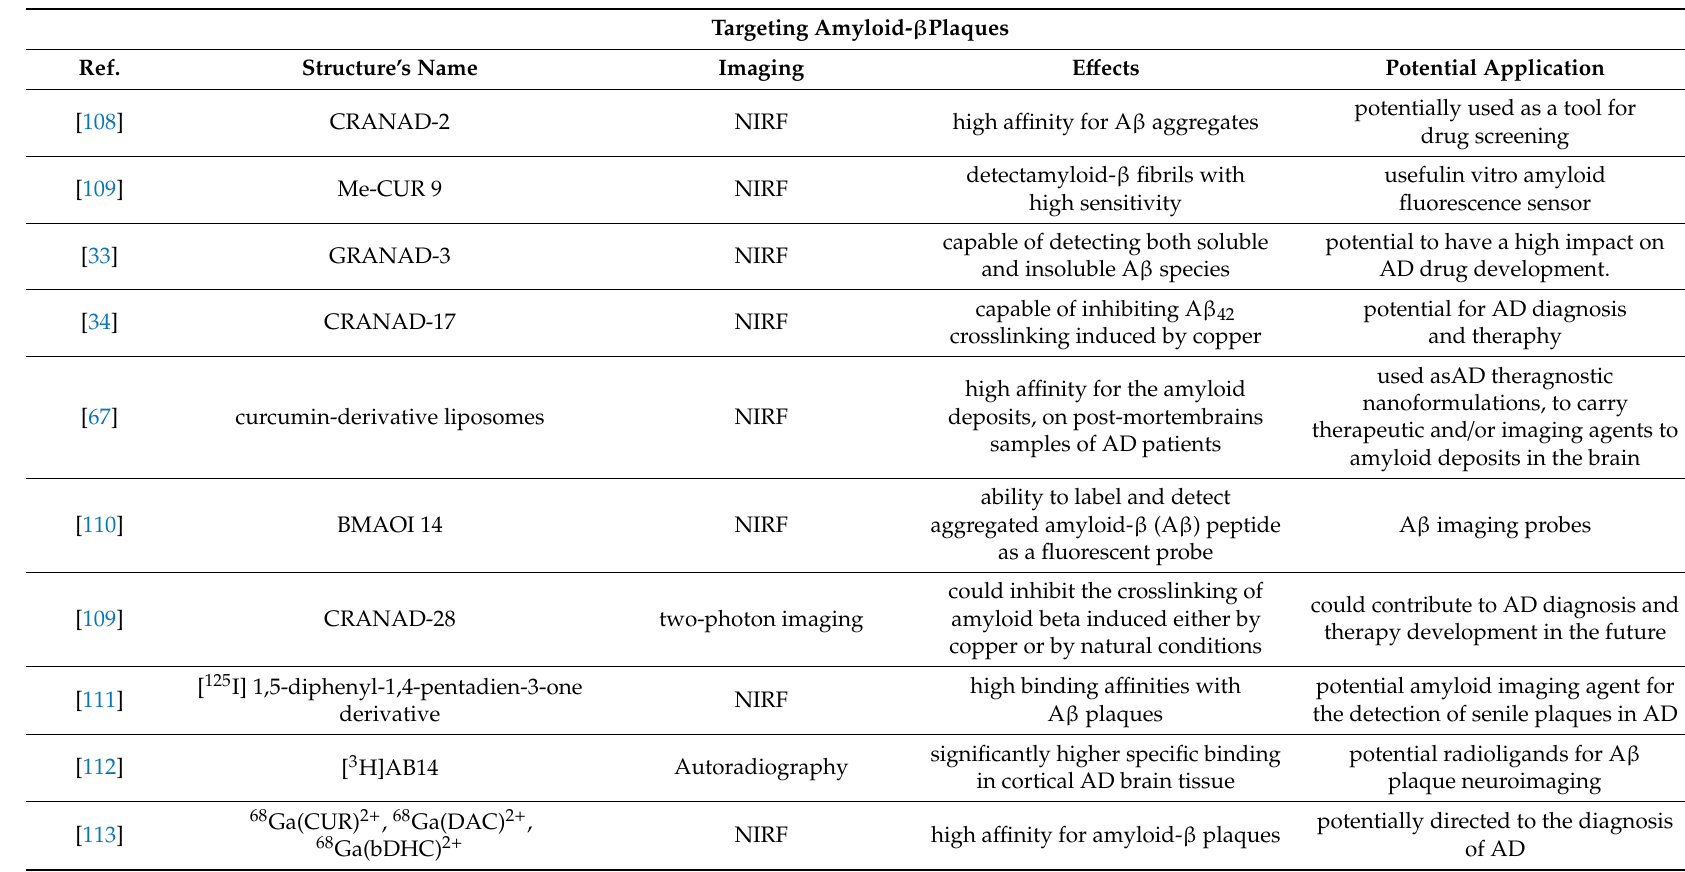
Table 3. Curcumin-probes as potential therapeutic and diagnostic agents for